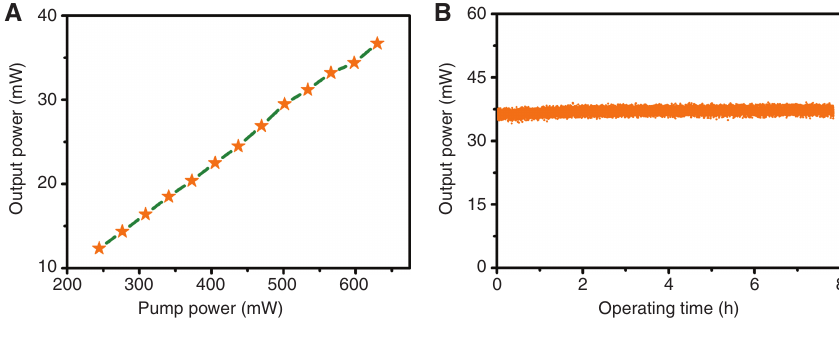
Figure 4: Output power and stability of laser. (A) The law of output power increasing with pump power; (B) Long time output power monitoring. Table 2: Comparisons of mode-locked lasers based on some SAs.